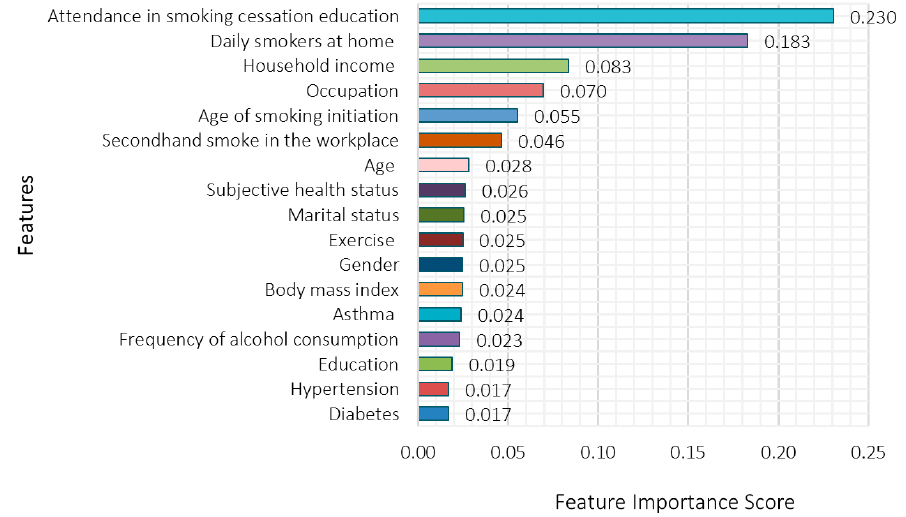
Figure 7. Feature Importance of Synthetic Minority Over-Sampling Technique (SMOTE) with the Random Forest (RF) model.